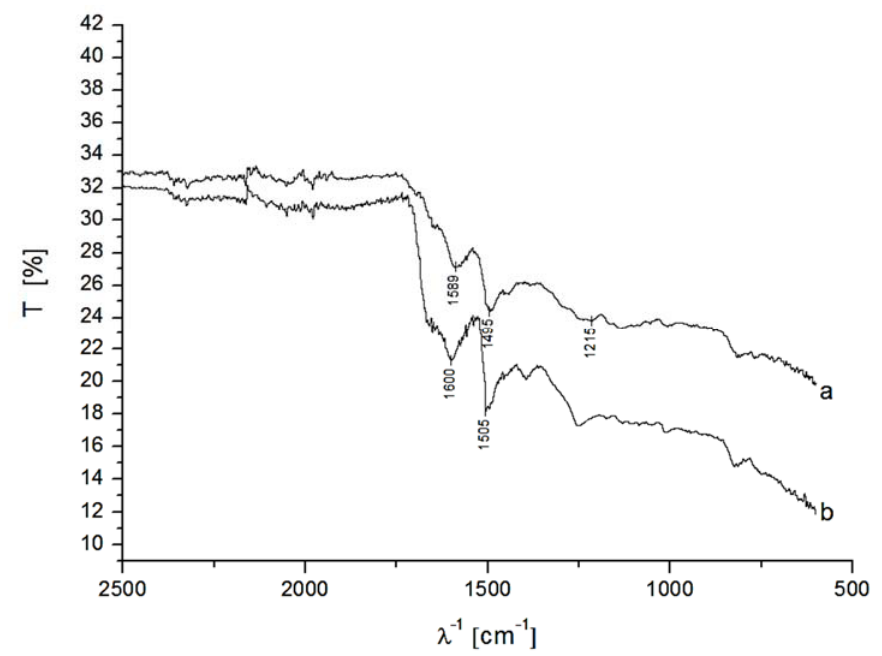
Figure 3. Fourier transform infrared spectroscopy (FTIR)-spectra of MWCNT-P(AMB-A) ( a ) and MWNT-P(AMB-A)-PDA ( b